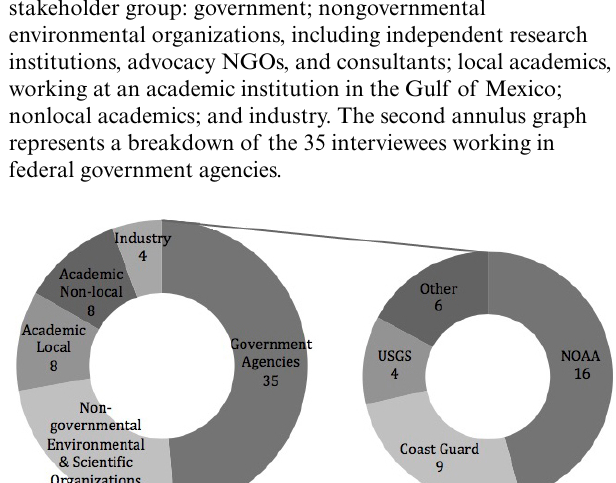
Fig. 3 . An example root cause tree that illustrates how asking “why” many times yields a causal chain with a leverage point